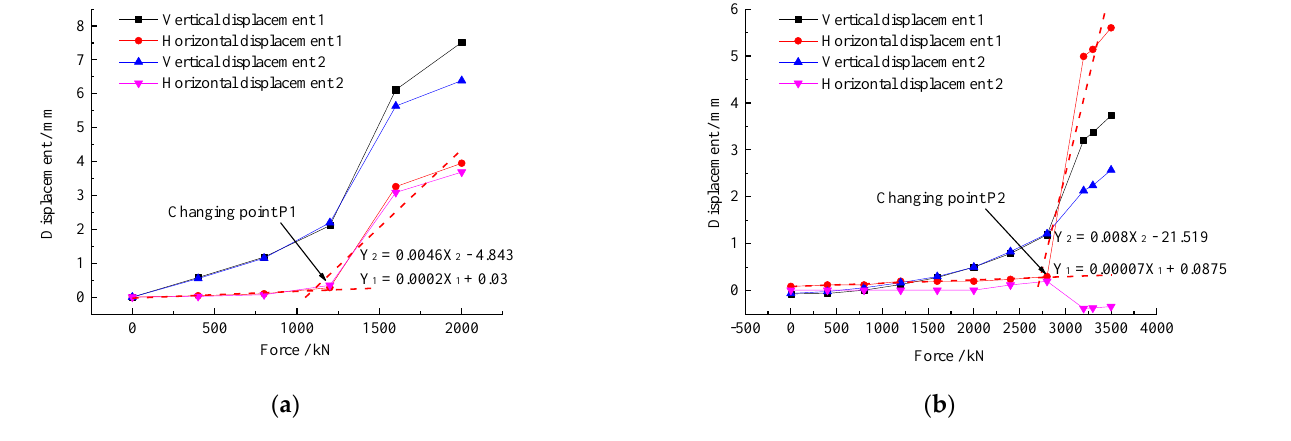
Figure 13. ( a ) Force – displacement curve of the main arch side; ( b ) force – displacement curve of the back wall side.